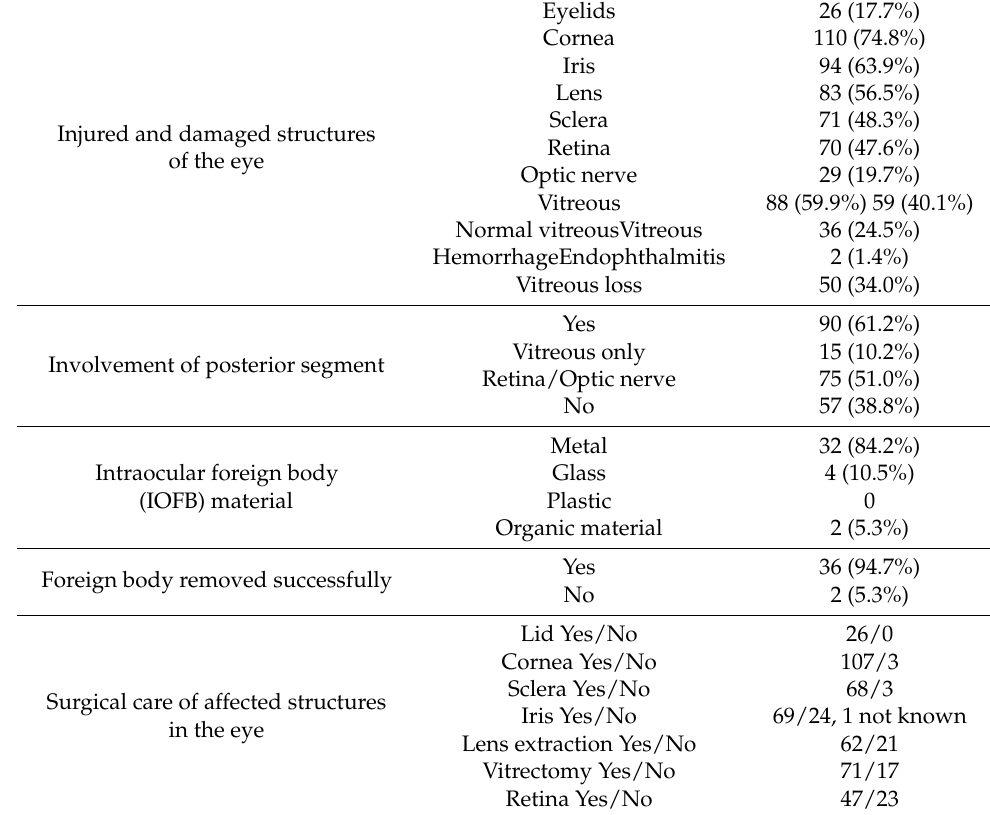
Table 4. Detailed injury characteristics and types of intraocular foreign body